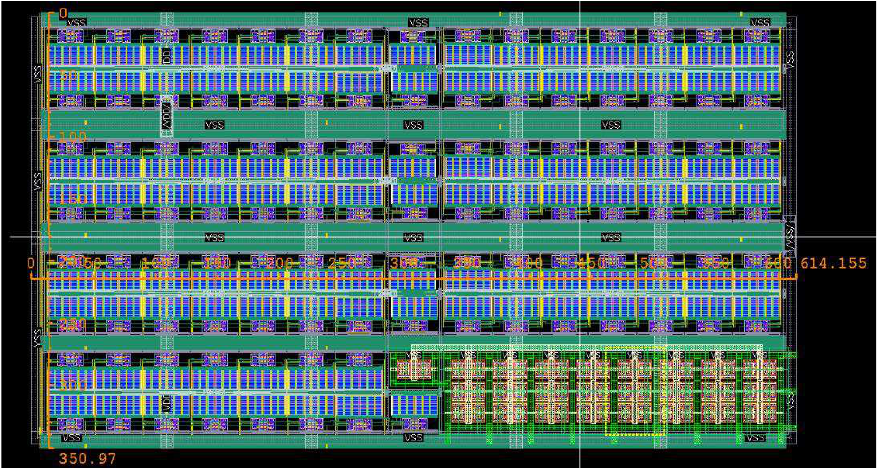
Figure 28. Layout design of the implemented tetrapolar bioimpedance measurement.